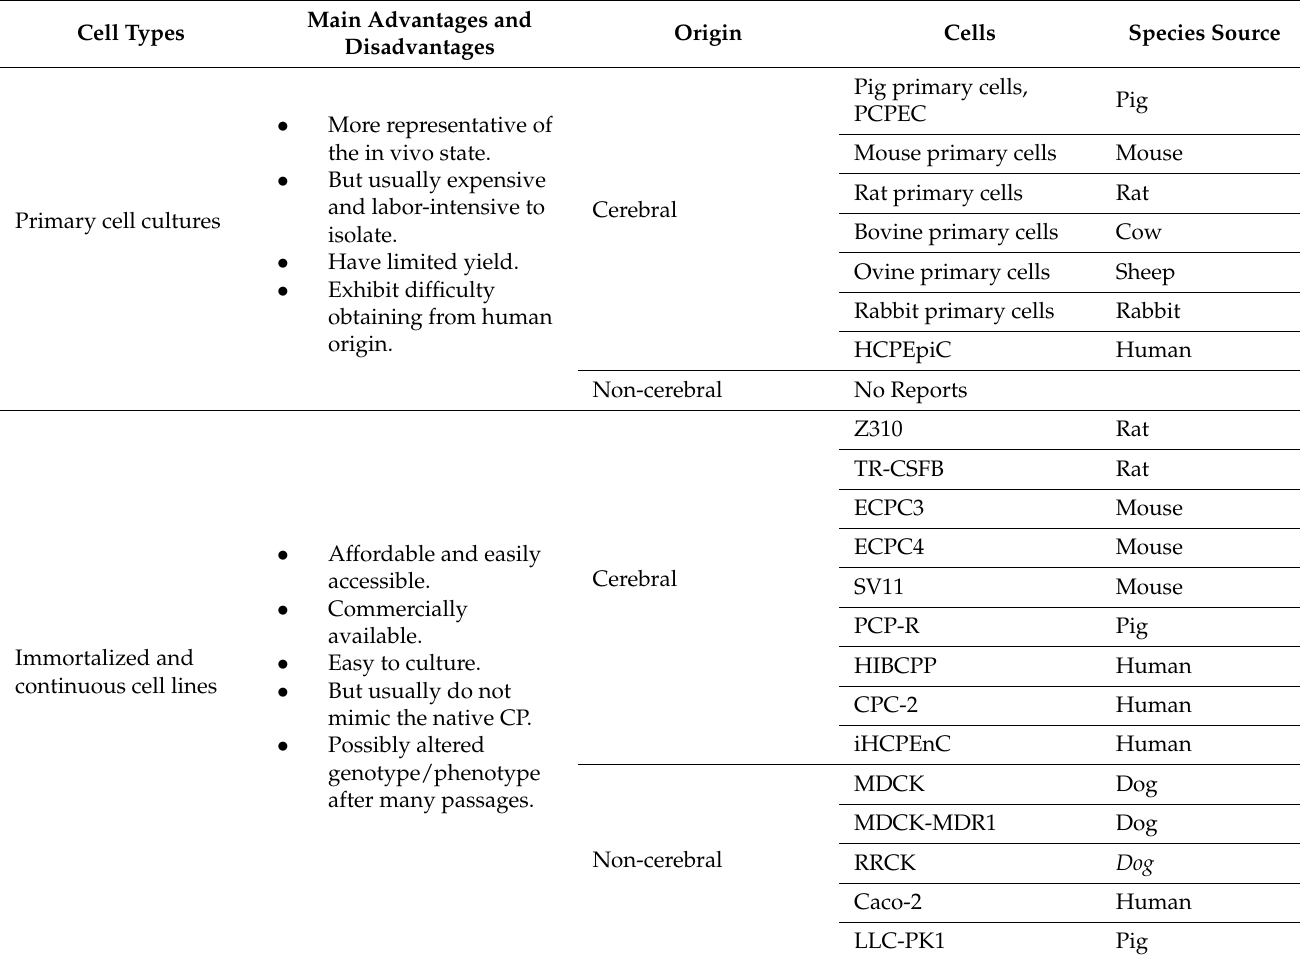
Table 3. Summary of available cells